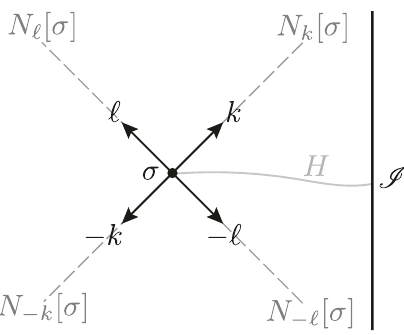
Figure 3 . An illustration of the four null normals of a surface σ (here shown to be homologous to I ) together with the corresponding null